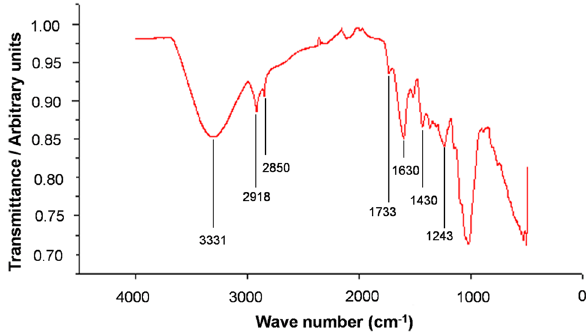
Fig. 1 FTIR spectrum of Artocarpus nobilis fruit